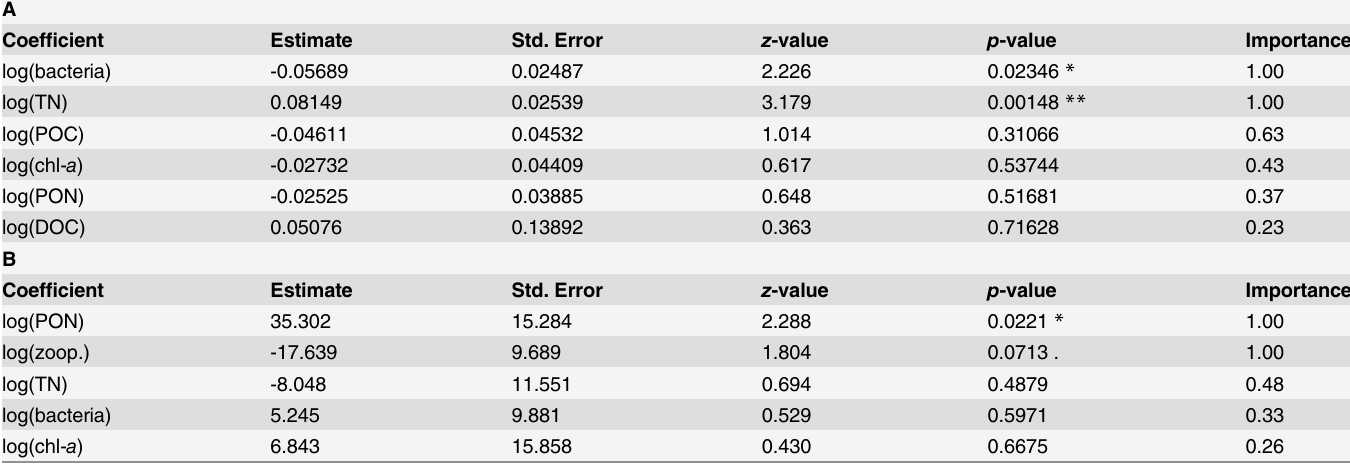
Table 2. Variables included in the six top models to predict pH and pCO 2 .